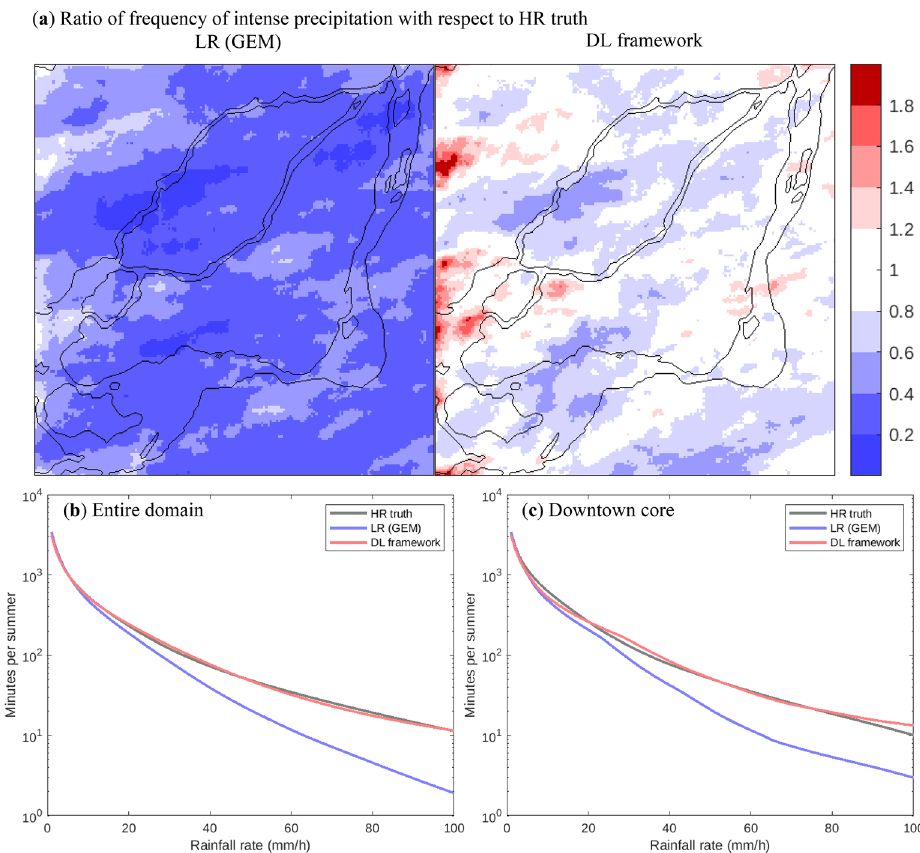
Fig. 4 a Ratio of spatial frequency of rainfall intensity above 50 mm/h with respect to HR truth, from LR GEM (left) and DL model (right). b Frequency–intensity relationships for the three datasets in a , over the entire HR domain. c As b , but for Montreal’s downtown